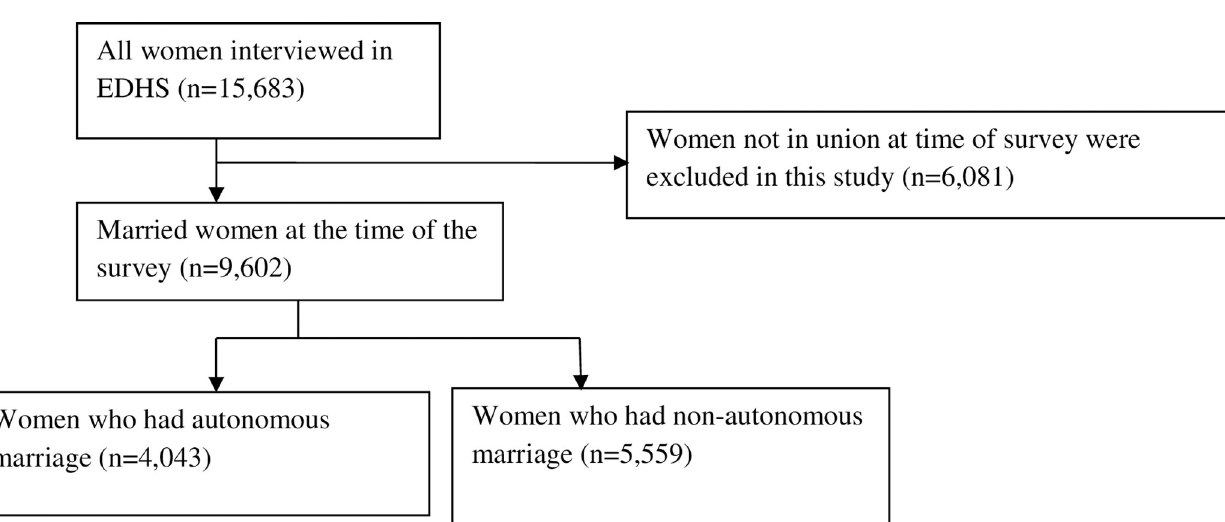
PLOS ONE | https://doi.org/10.1371/journal.pone.0271879 August 18,